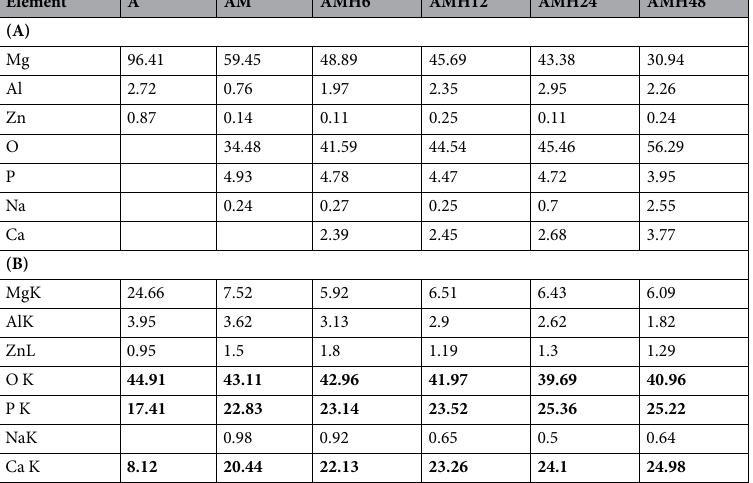
Table 1. Composition on the surface of the A, AM, AMH6, AMH12, AMH24 and AMH48 groups (A) before and (B) after immersion in HBSS for 14 days (at.%).